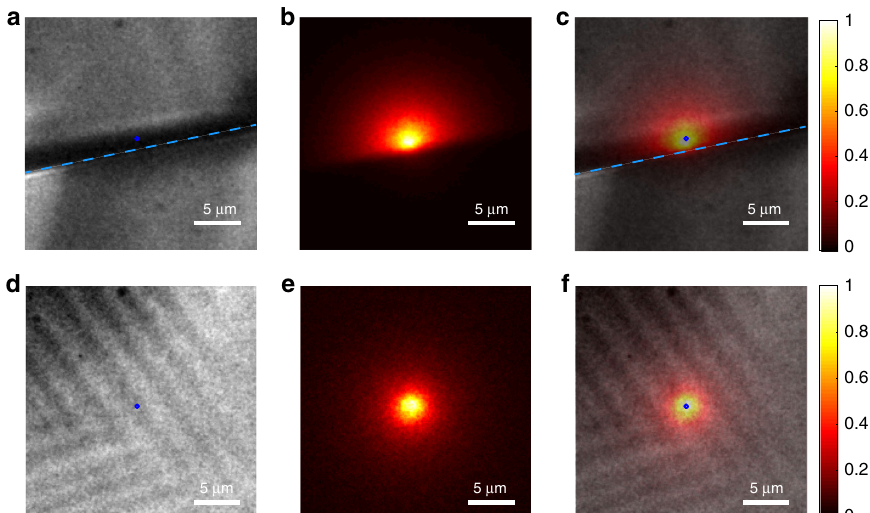
Fig. 3 Capture carrier transport with photoluminescence (PL) imaging. a Polarized optical microscope image, ( b ) PL intensity image and ( c ) composite image of a MAPbI 3 multi-crystal with GBs. The blue dashed line indicates the position of GB. d Polarized optical microscope image, ( e ) PL intensity image and ( f ) composite image of a MAPbI 3 single crystal with TBs. The PL excitation position is indicated by the blue circle.